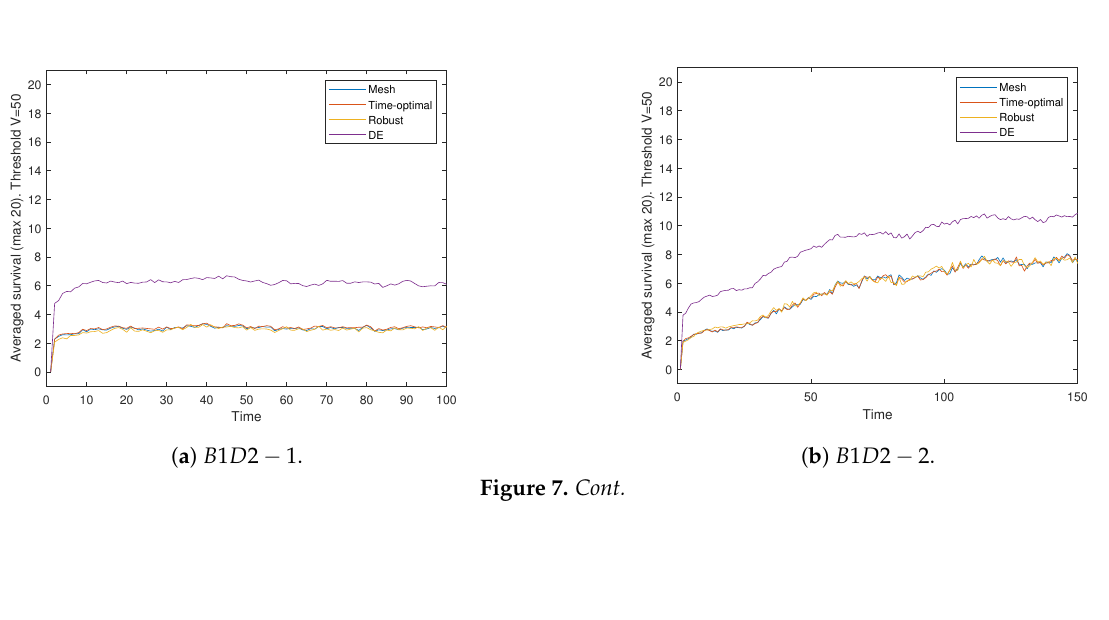
Figure 6. Results obtained using dynamic 1.